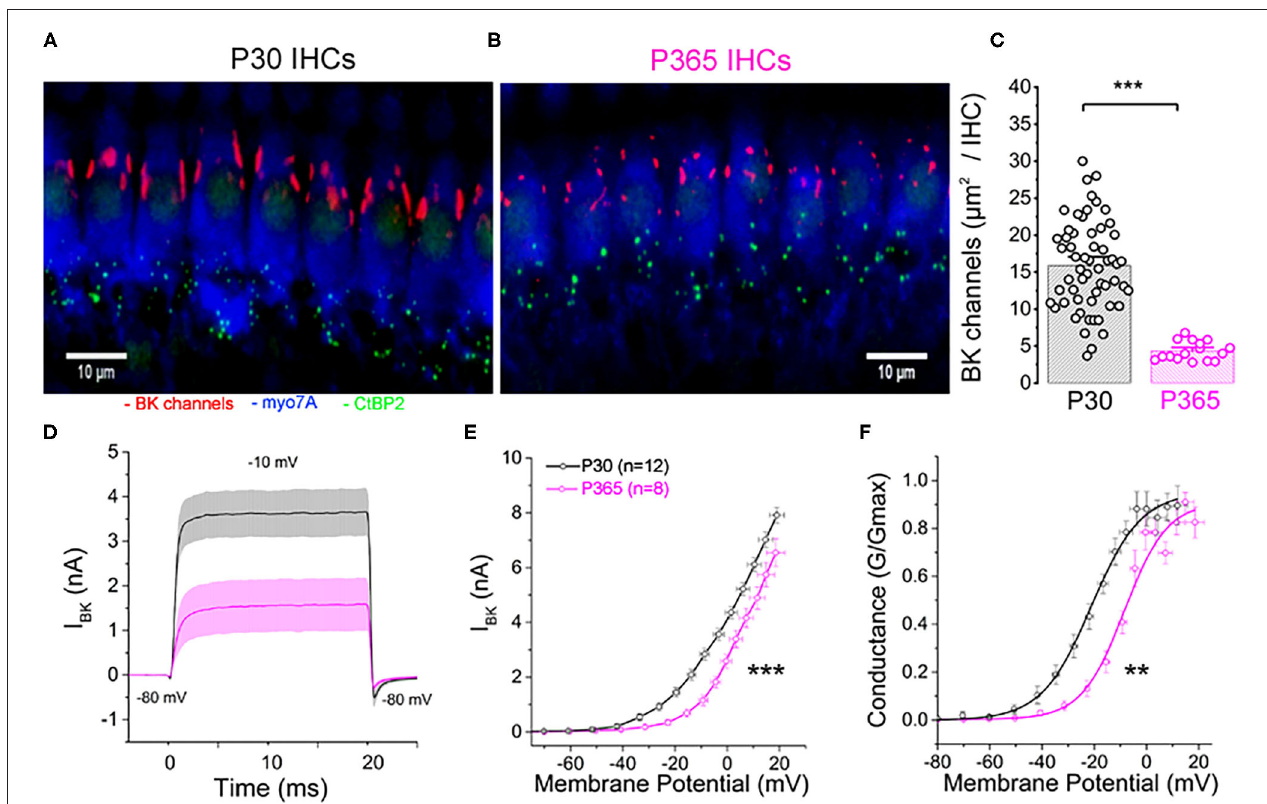
FIGURE 10 | Immunofluorescent confocal imaging of BK channels in aging IHCs. (A) Numerous large BK channel clusters (red) are localized extrasynaptically below the cuticular plate of IHCs in young mature P30 C57BL6/J mice. (B) Note the strong reduction in size of the BK channels clusters in IHCs of old P365 C57BL6/J mice. (C) Histogram comparing the total surface area covered by the BK channel clusters per IHC in the mid-turn cochlea (region encoding 8–16kHz). The total number of IHCs analyzed was 58 and 16 from P30 ( n = 3) and P365 ( n = 3) mice, respectively. Asterisks indicate statistical significance with p < 0.05 ( p = 1.12 E − 7; unpaired t -test). (D) Comparative fast outward potassium currents (IKf), carried by BK channels, recorded from P30 (black, n = 12) and P360 (pink, n = 8) IHCs when using a brief depolarization step of 20ms from − 80 to − 10mV. (E) Comparative BK current–voltage curves ( n = 12 and 8 IHCs, respectively, in P30 and P360 mice, from three mice at each age). Significantly different two-way ANOVA, p = 2.7 E − 8. IKf was measured 2.5ms after the onset of the voltage-step stimulation. (F) Comparative BK conductance fitted with a Boltzman function indicated a V1/2 of − 20.5 ± 5.7mV in P30 IHCs and of − 13.7 ± 1.4mV in P365 IHCs, respectively (unpaired t -test, p = 0.009). Note that voltage error across series resistance (Rs = 5 ± 2 M Ω ) and leak current were compensated for each IHC. All values are expressed as means ±